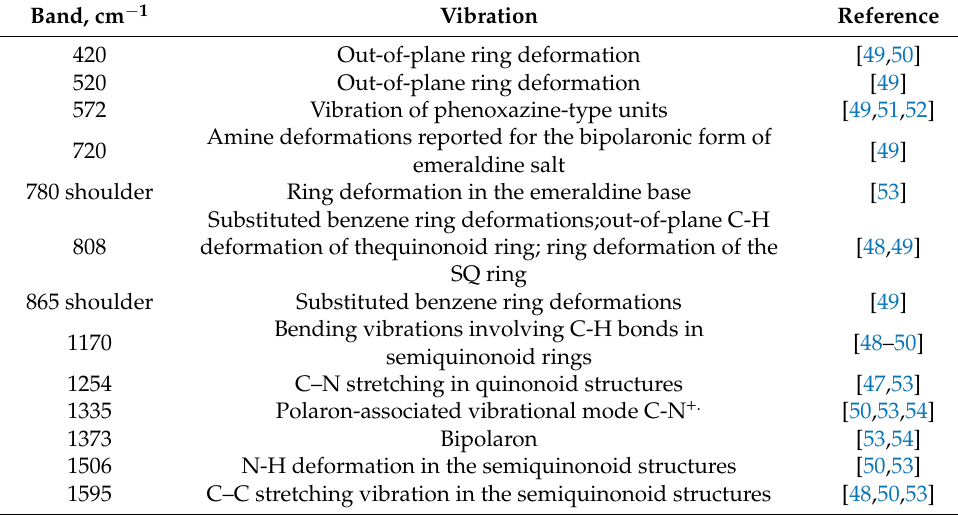
Table 1. Main characteristic vibration bands of the synthesized PANI.